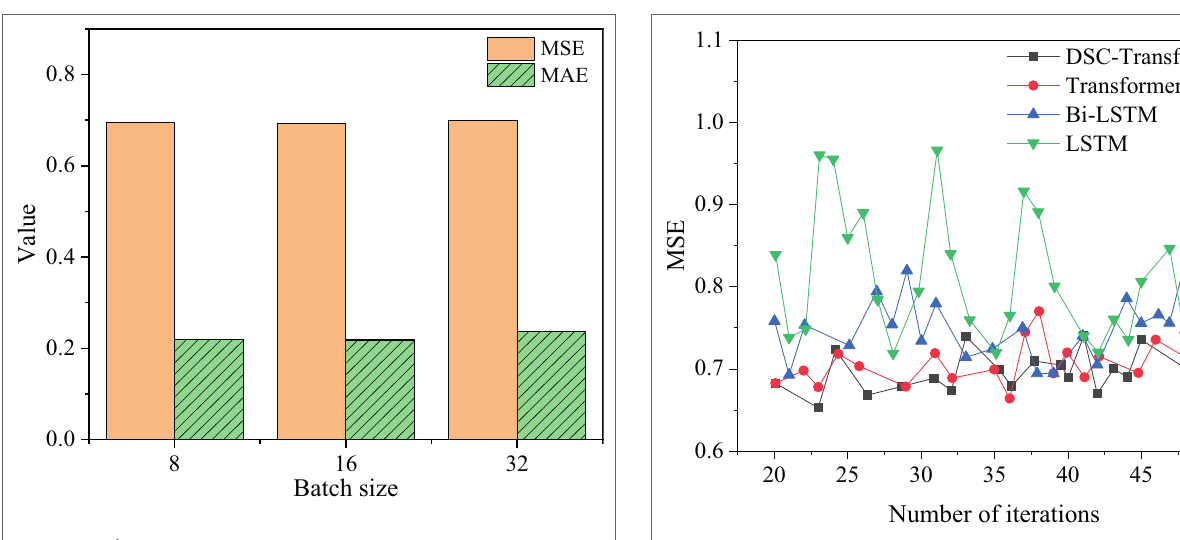
FIGURE 10 | The corresponding MSE and MAE values when the learning rate is 1e-5. FIGURE 11 | Comparison of MSE values corresponding to the model when using different algorithms.